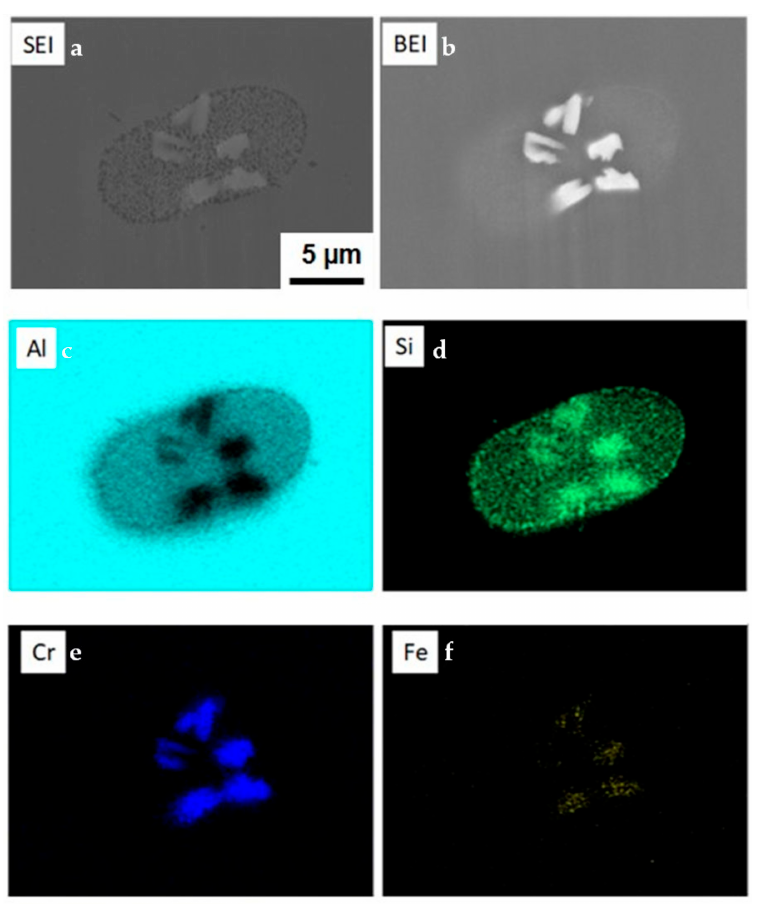
Figure 14. Typical SEM views ( a , b ) and elemental mappings ( c – f ) of particles of third